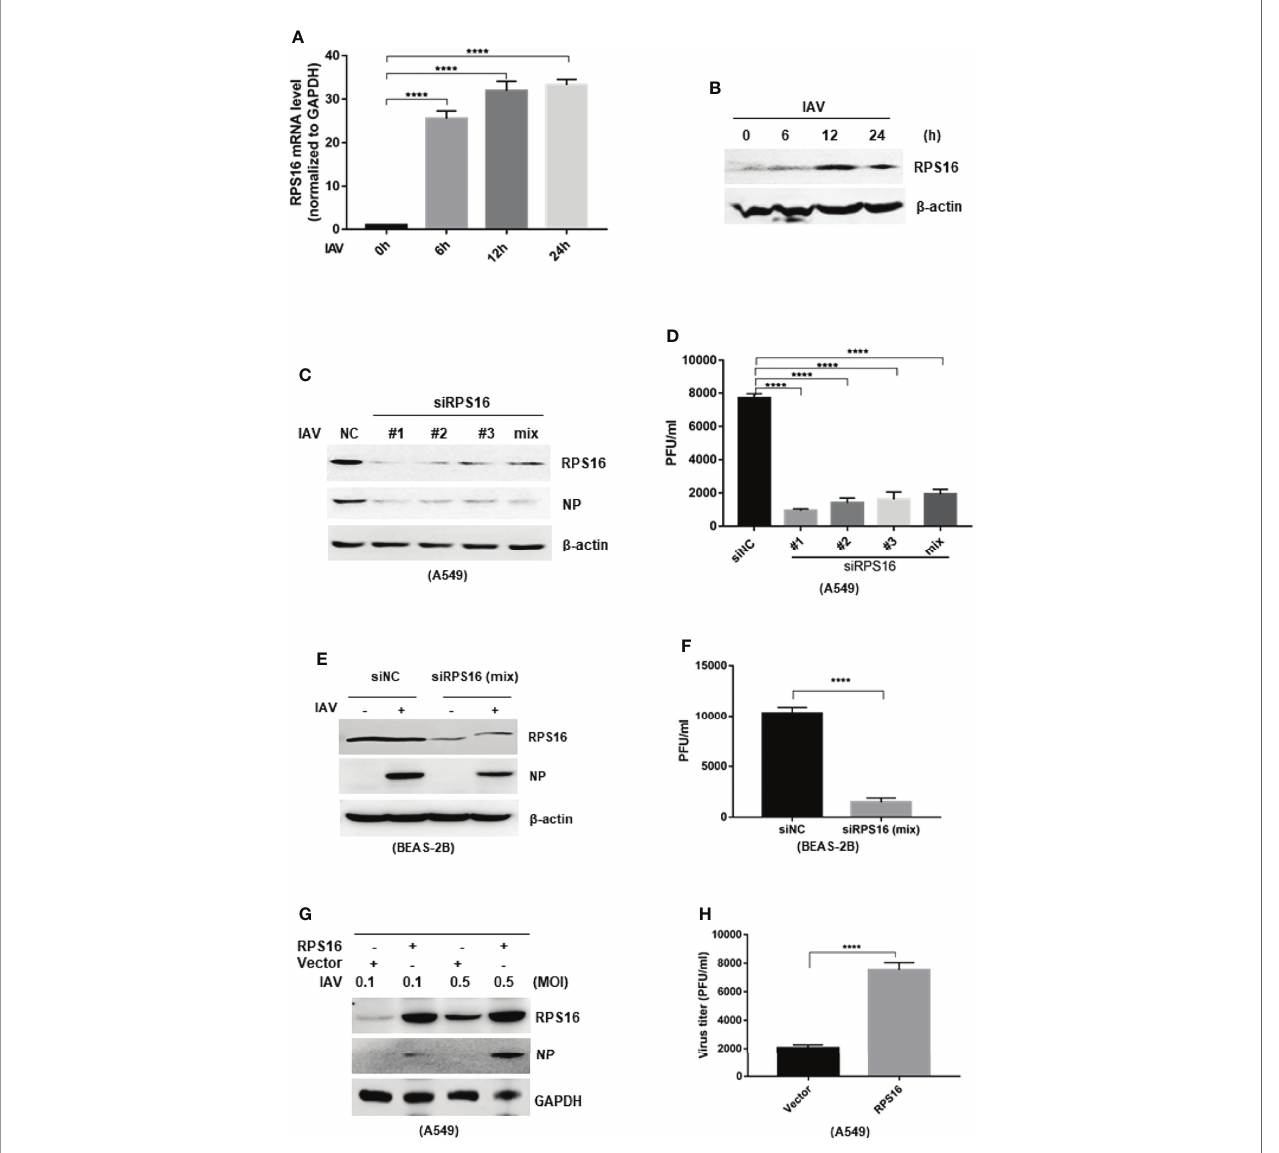
FIGURE 4 | RPS16 promotes IAV replication. A549 cell was infection with in fl uenza A/wsn/1933 virus (MOI=1) for 0, 6, 12 and 24h; (A) the expression of RPS16 mRNA was detected by real-time qPCR and normalized to expression of GAPDH. Data are the mean ± SD from three independent experiments, ****P < 0.0001 vs. 0h control cell by t -test; (B) the expression of RPS16 protein after IAV infection was detected by western blot. Data are representative of at least three independent experiments. (C and D) A549 cells were transfected with siNC or siRPS16. After 48 h, the cells were infected with in fl uenza A/wsn/1933 virus of 0.1MOI, the expression of in fl uenza NP protein was detected by westen blot (C) ; (D) The virus titer in the supernatants was infected to MDCK cell and measured the viral titer by plaque forming assay, data were shown as mean ± SD (**p < 0.01, ***p < 0.001). (E and F) BEAS-2B cells were transfected with siNC or siRPS16. After 48 h, the cells were infected with in fl uenza A/wsn/1933 virus (MOI = 0.1), the expression of in fl uenza NP protein was detected by westen blot (E) . The virus in the supernatants was infected to MDCK cell and measured the viral titer by plaque forming assay (F) , data were shown as mean ± SD (** p < 0.01, *** p < 0.001). (G, H) A549 cells were transfected with RPS16 expressing vector or control vector. After 48 h, the transfected cells were infected with in fl uenza A/wsn/1933 virus of 0.1 MOI and 0.5 MOI, the expression of in fl uenza NP protein was detected by westen blot (E) ; the virus in the supernatants infected with 0.1 MOI was measured the viral titer by plaque forming assay (F) . Data were shown as mean ± SD (** p < 0.01, *** p < 0.001). Data are the representative of three independent